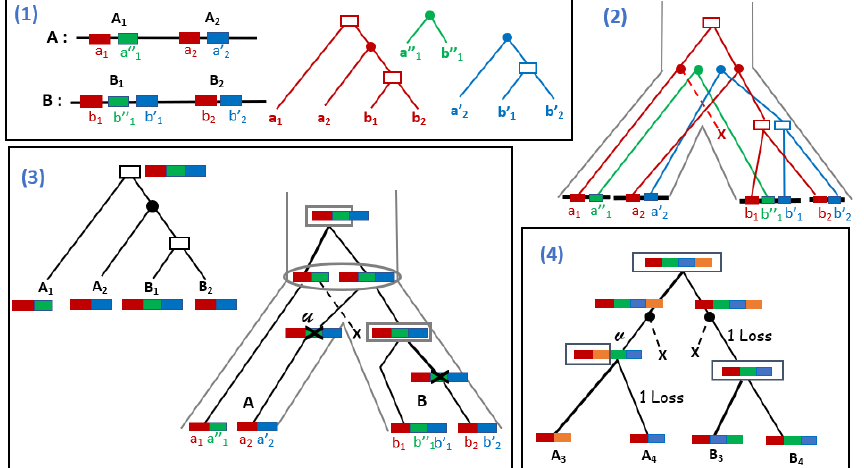
Figure 5. ( 1 ) Three gene families (red, blue and green) organized into four syntenies X = { A 1 , A 2 , B 1 , B 2 } located in two genomes A and B , and the reconciled gene trees for each gene family (node labels are represented as in Figure 4). Gene orders, as well as gene trees are consistent; ( 2 ) The gene trees embedded in the species tree S = ( A , B ) , illustrating an independent evolutionary history for each gene family; ( 3 ) A synteny tree for X (left) and a Super-Reconciliation, i.e., an evolutionary scenario of segmental duplications and losses (right), embedded in the species tree S . Each node of the Super-Reconciliation is labeled by the type of event (duplication represented by a rectangle, speciation by an oval and loss by a cross) and the segment affected by a duplication (inside the rectangle) or a loss (marked by the cross). The bold edge incident to a duplication node is the one leading to the duplicated synteny; ( 4 ) An unordered Super-Reconciliation for a new set of syntenies { A } that are not order-consistent. The minimum number of duplications and losses 3 , A 4 , B 3 , B 4 explaining this synteny tree is 5, but rearrangements are still required on some branches as orders are not